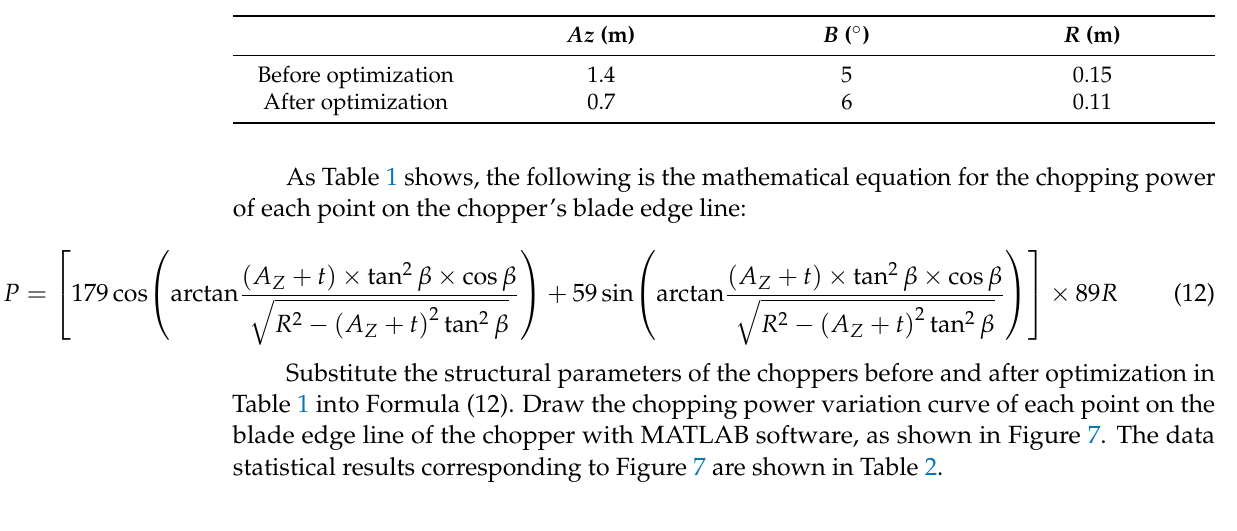
Table 1. Structure parameters of the choppers before and after